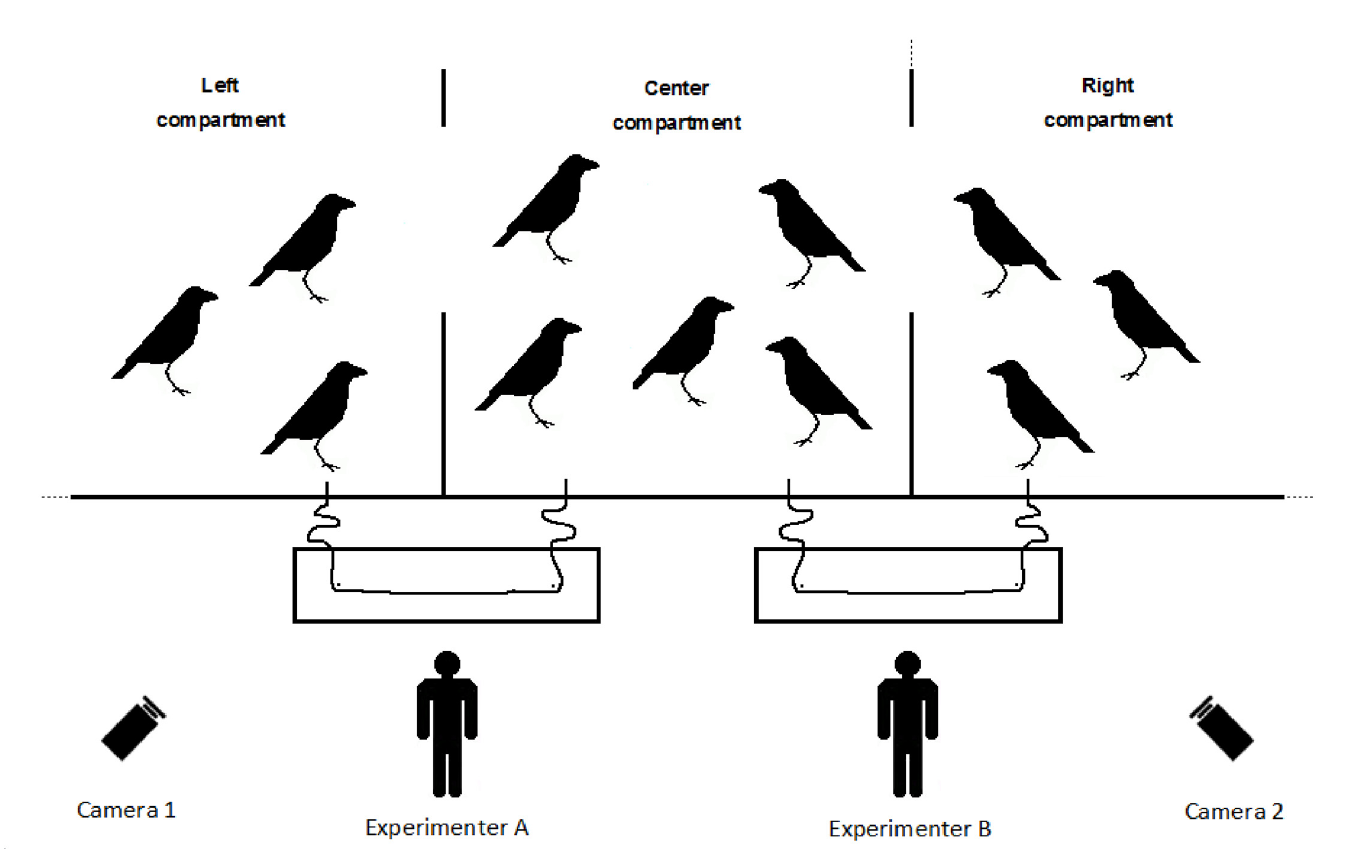
Fig 3. Setting of experiment No. 3. The subjects could freely move around in the whole aviary. We tested if friends stay close to each other in the center compartment while pulling with another bird (tolerance of proximity) or if friends actually cooperate with each other at one of the string pulling apparatuses (actual partner choice based on relationship quality as a